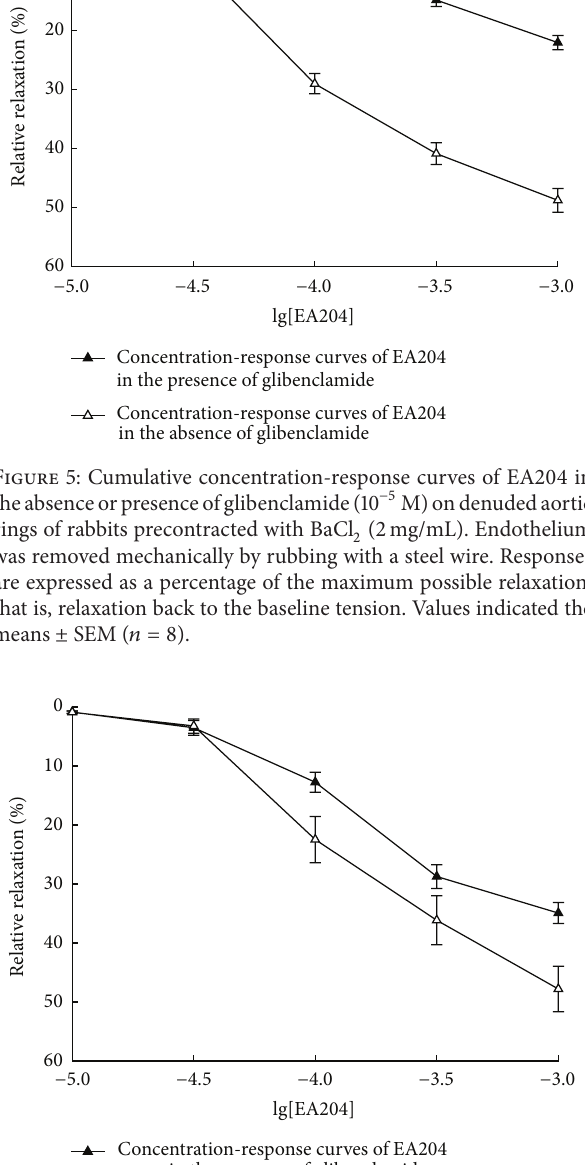
K + channels opening may contribute to the vasorelaxation effect of